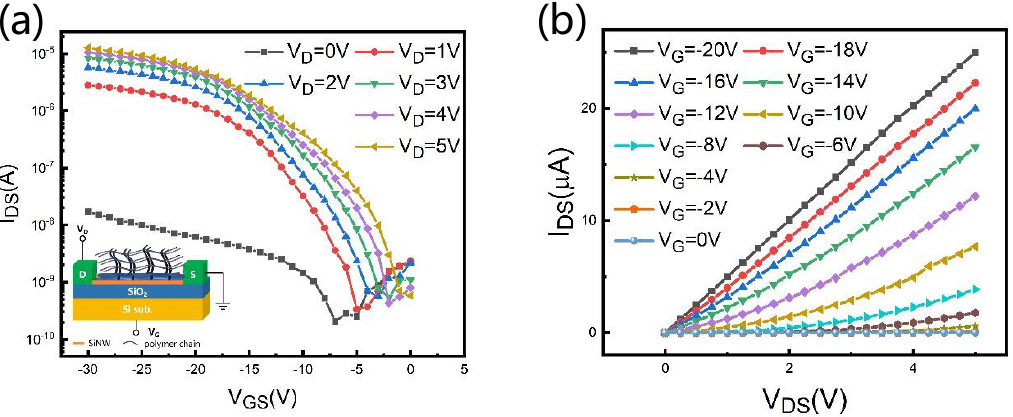
Figure 3. Electrical characteristic curve of SiNW FET after polymer-hydrogel coating, ( a ) Transfer characteristic curve (I DS –V GS ), the inset is a schematic diagram of device detection. ( b ) Output characteristic curve (I DS –V DS